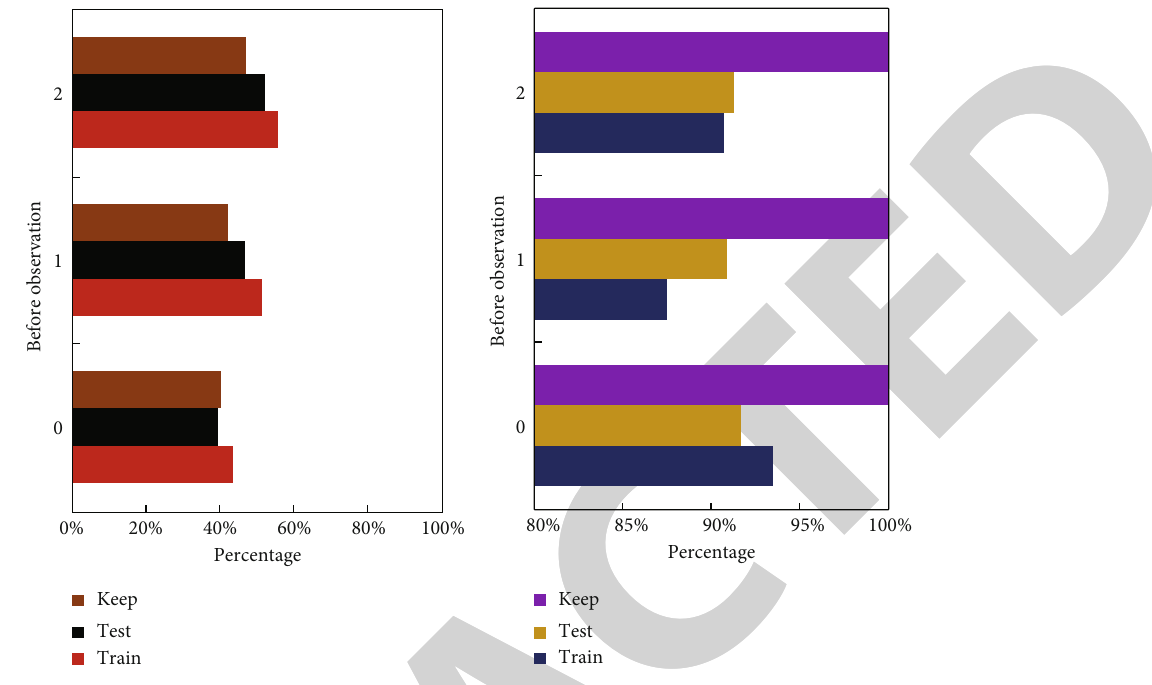
Figure 3: Neural network complex model network performance